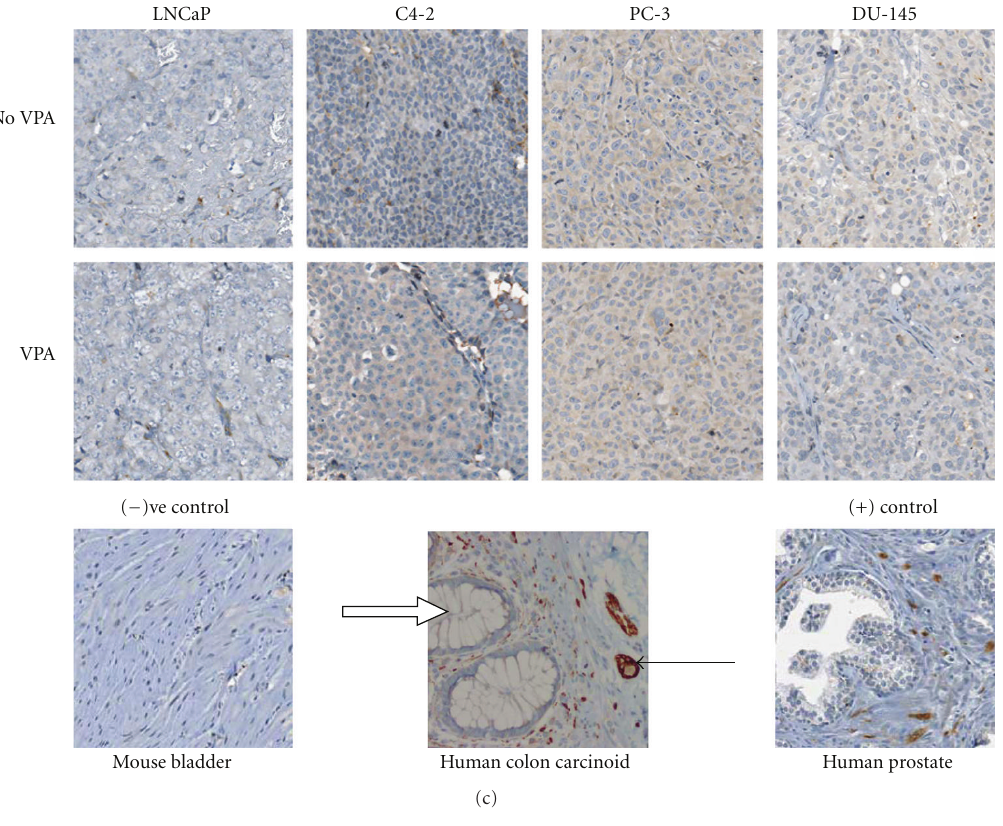
Figure 4: Chromogranin A staining in prostate xenografts animals treated with or without VPA. (a): Representative images of CgA staining for xenograft sections from control and VPA-treated groups: LNCaP, C4-2, PC-3, and DU-145 (Scanned at 20X magnification using the APERIO imaging system). The tissue specimens of human pancreas and human prostate were positive internal controls for CGA staining, while another human prostate section served as a negative control. (b) Synaptophysin staining in prostate xenografts animals treated with or without VPA. A: Representative images of synaptophysin staining for xenograft sections from control and VPA-treated groups: LNCaP, C4-2, PC-3, and DU-145 (Scanned at 20X magnification using the APERIO imaging system). The tissue specimens of human pancreas and mouse colon were positive internal controls for synaptophysin staining, while mouse bladder as negative internal controls. (c) NCAM staining in prostate xenografts animals treated with or without VPA. (a): Representative images of CD56 staining for xenograft sections from control and VPA-treated groups: LNCaP, C4-2, PC-3, and DU-145 (scanned at 20X magnification using the APERIO imaging system). The tissue specimens of human colon carcinoid and normal human prostate were positive internal controls for NCAM staining, while mouse bladder was a negative